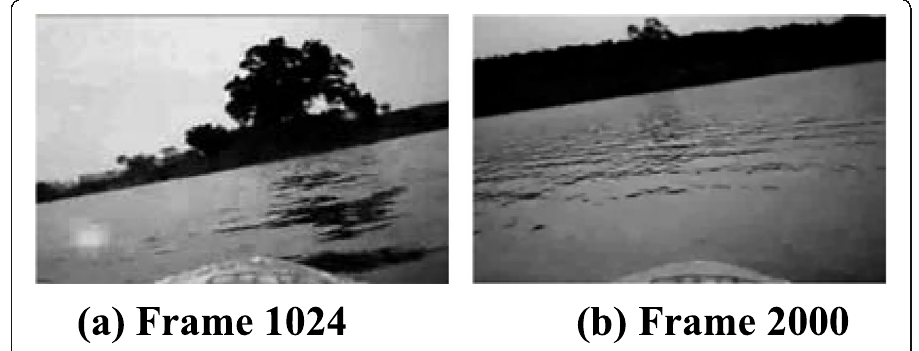
Fig. 2 Original images. a Frame 1024. b Frame